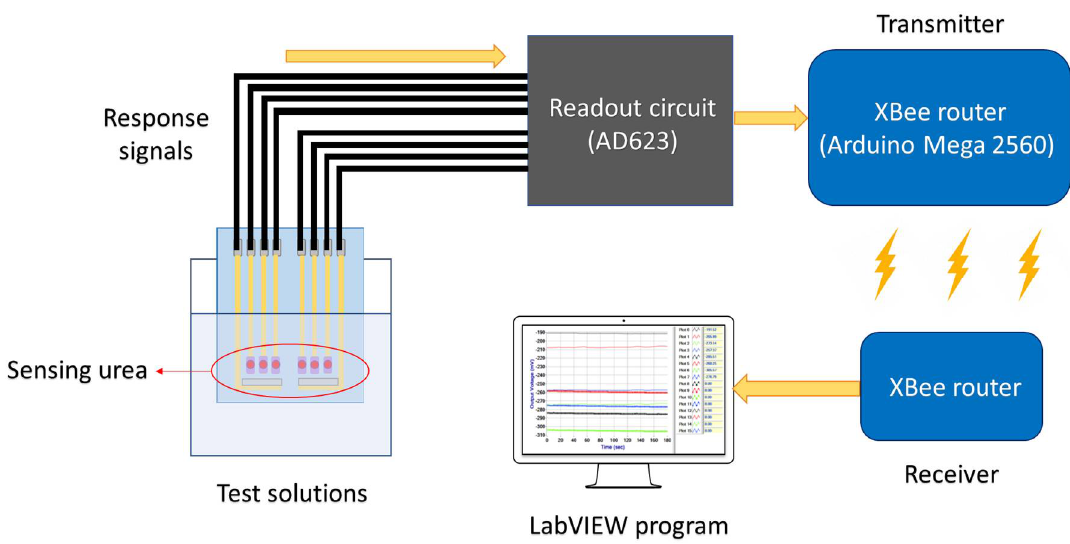
Figure 1. The schematic of the wireless measurement system, which includes a urea biosensor, a readout circuit, an XBee module, and a computer with the LabVIEW program.